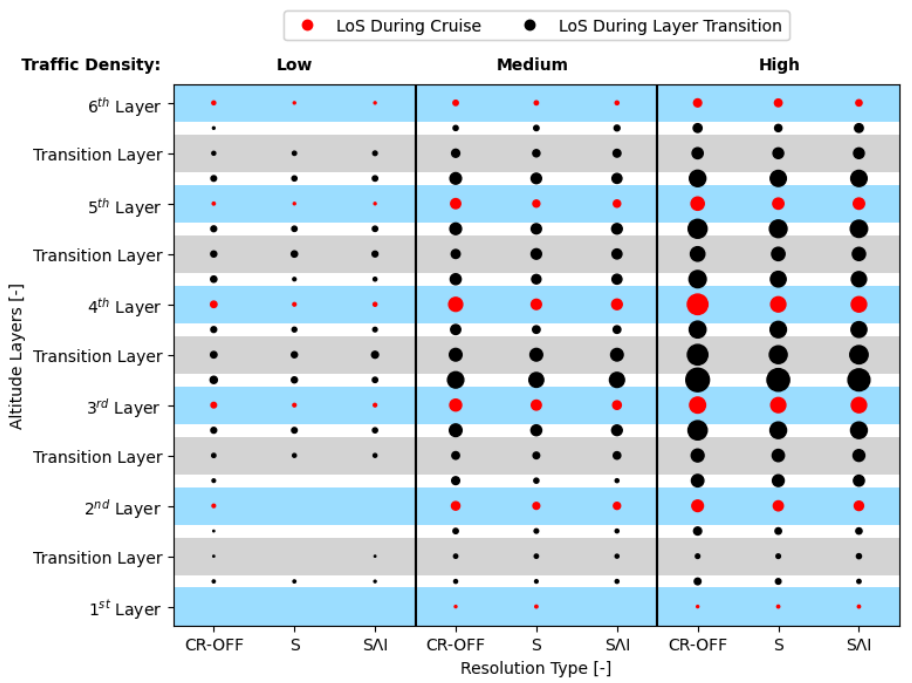
Figure 22. Schematic view of the altitude at which losses of separation (LoSs) occur with multiple layers. The size of the points varies between a maximum value of 182 and a minimum value of 3 LoSs.